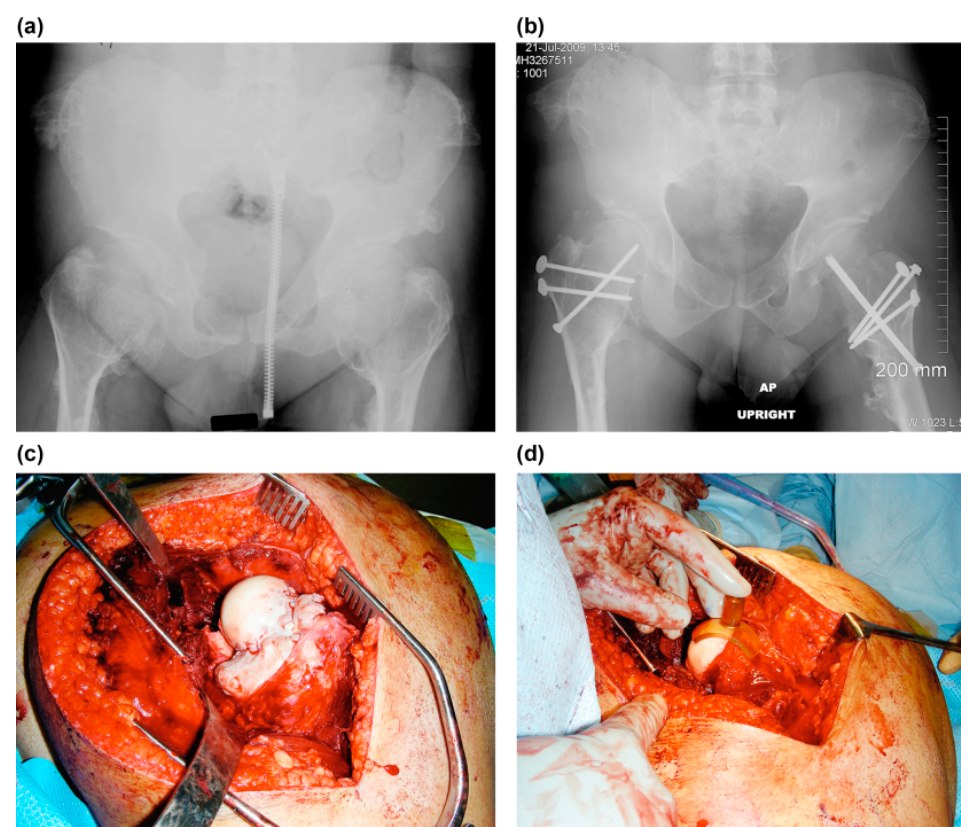
Figure 3. The images show the case of a 23-year-old man with symptomatic bilateral femoroacetabular impingement pain and limitation of motion (case no. 5). ( a ) Preoperative anteroposterior radiograph shows a large bump at the medial side of the femoral neck. Neck–shaft angle of the femur was within tolerable range (Rt, 140; Lt, 150). The containment of the hip was normal. ( b ) Postoperative anteroposterior radiograph of the hip. Mediolateral neck–shaft ratio improved from 6.7 to 1.6 on the right hip, 3.6 to 1.7 on the left hip. A cortical or cannulated screw was inserted through the femoral neck to prevent femoral neck fracture and the osteotomized greater trochanter was fixed with two-three 3.5 mm cortical screws. ( c ) Intraoperative photograph of the left hip. ( d ) The osteochondroplasty of the femoral neck can be performed with small osteotomes and a high-speed burr. When the resection is satisfactory, a special template (spherometer gage) can be used to check the sphericity of the remaining femoral head. The neck–shaft ratio improved from 3.6 to 1.7 mediolaterally and 2.7 to 1.3 anteroposteriorly.